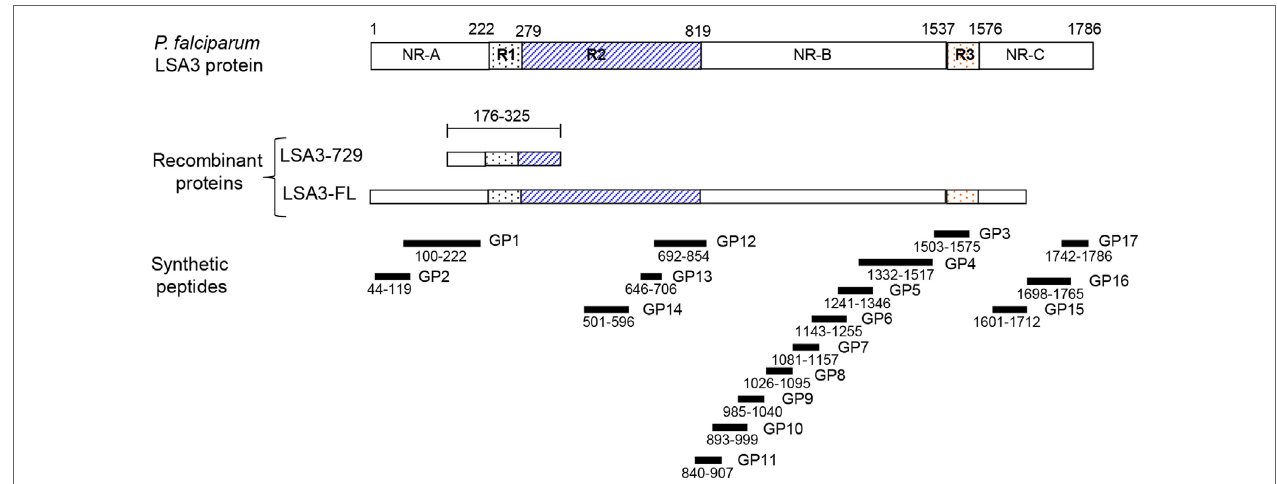
FigUre 1 | Schematic representation of liver stage antigen 3-full length (LSA3-FL) and liver stage antigen 3-729 (short form) (LSA3-729) constructs derived from Plasmodium falciparum liver stage antigen 3. Shown is the localization of the repetitive (R1, R2, R3) and non repetitive (NR-A, NR-B, NR-C) regions, the synthetic peptides (LSA3-GP). The numbers indicate amino acid positions in 3D7